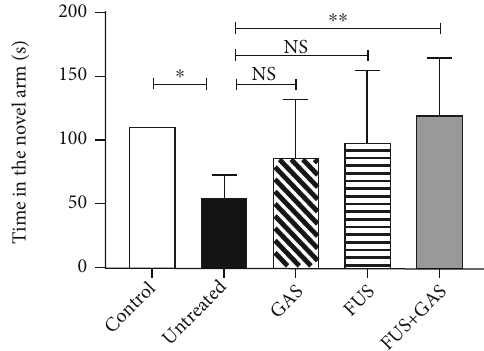
Figure 7: Protective e ff ect of combined treatment (FUS+GAS) on short-term memory of AD-like mice. The time that AD-like mice spent in the novel arm of Y-maze was signi fi cantly shortened in comparison to control mice while prolonged via the combined treatment. Each symbol represents the mean ± SD ; ∗∗ P < 0 : 01 against untreated mice; ∗ P < 0 : 05 against untreated mice. One- way ANOVA; n = 6 per